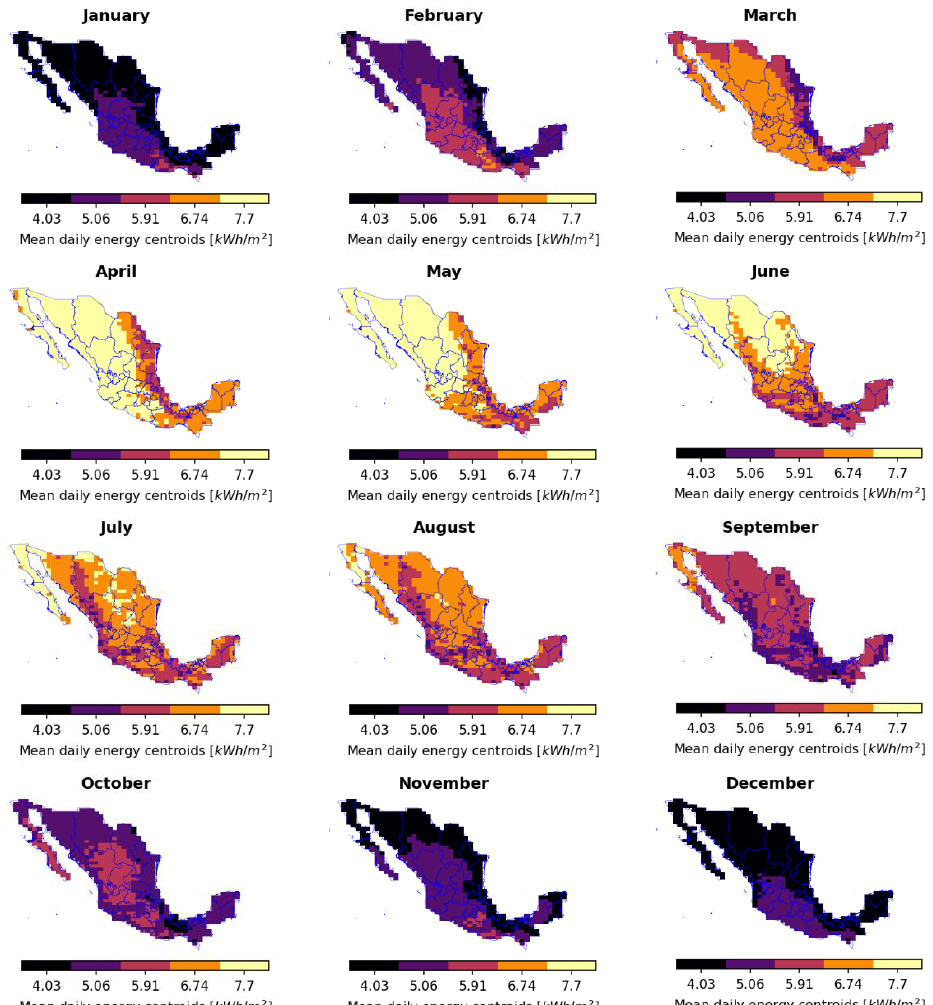
Figure 5. Cluster maps of mean daily solar energy for each month in